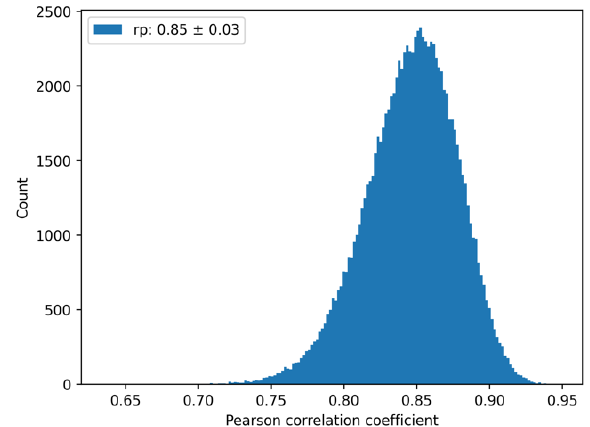
Figure 2. Experimental “self-correlation”. Histogram of the Pearson correlation coefficient samples from randomly generated sets. The average Pearson correlation coefficient and its standard deviation are reported in the figure legend.